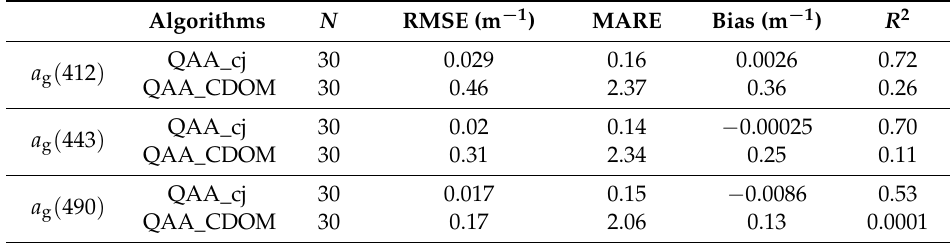
Table 7. Comparison statistics of QAA_cj and QAA_v6 based on in situ dataset and GOCI-derived